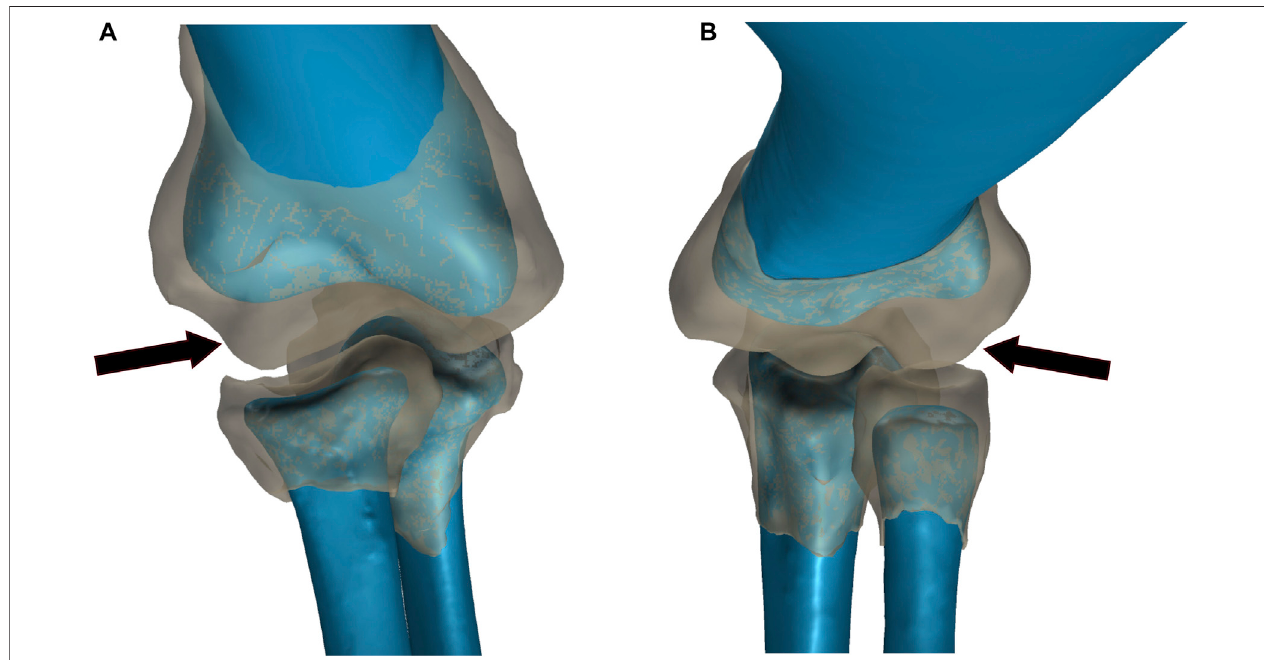
FIGURE2| Comparison ofboneandarticularcartilagemorphologiesinextant taxa. (A) AmericanAlligatorrightelbow. (B) Chickenleftelbow.Bonemorphologyis displayedinblueandarticularcartilagemorphologyisdisplayed asasemi-transparentgrayoverlay. Theblackarrowsdenotetheanteriorsphericalprojectionofarticular cartilage on the lateral distal condyle of the